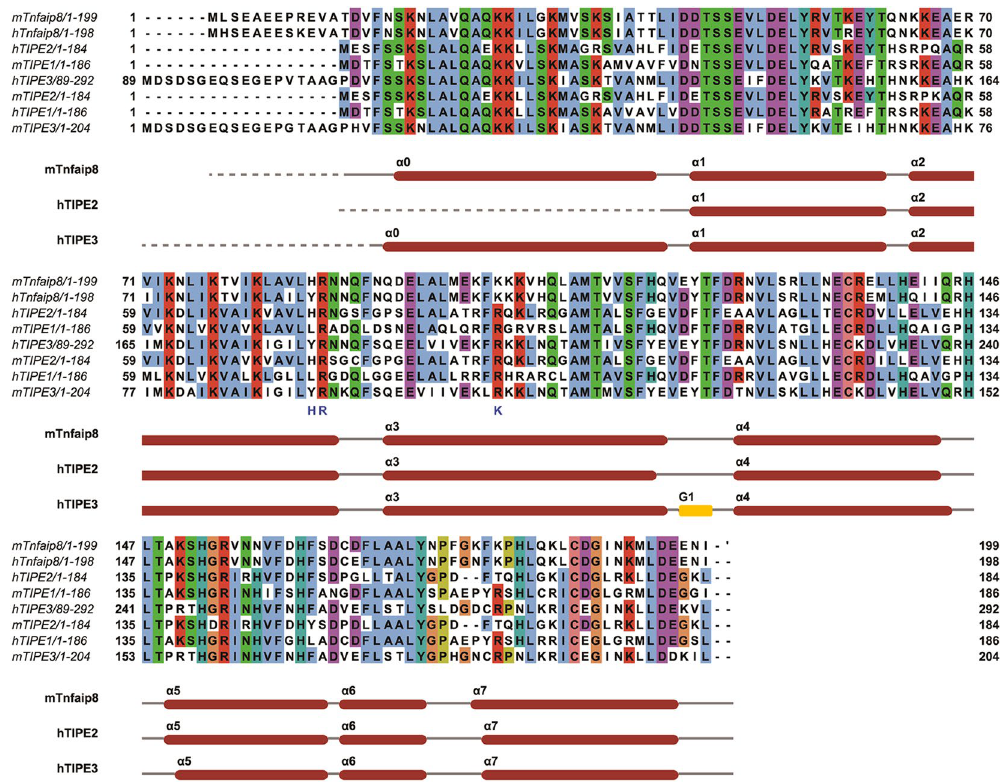
Figure 3. Sequence alignment of Tnfaip8 family members. Secondary structure elements of mTnfaip8, hTIPE2 and hTIPE3 are displayed and colored in red for α -helix, green for β -strand and yellow for 3 10 -helix. The blue characters represent key residues of mTnfaip8 for PE binding. Accession codes are BC009090.1 for Tnfaip8 from Mus musculus (mTnfaip8), AAH07014 for Tnfaip8 from Homo sapiens (hTnfaip8), BC032199.1 for TIPE1 from Mus musculus (mTIPE1), NP_001161414 for TIPE1 from Homo sapiens (hTIPE1), EDL38778 for mTIPE2 ( Mus musculus ), NP_078851 for TIPE2 from Homo sapiens (hTIPE2), NP_001028707 for TIPE3 from Mus musculus (mTIPE3), NP_997264 for TIPE3 from Homo sapiens